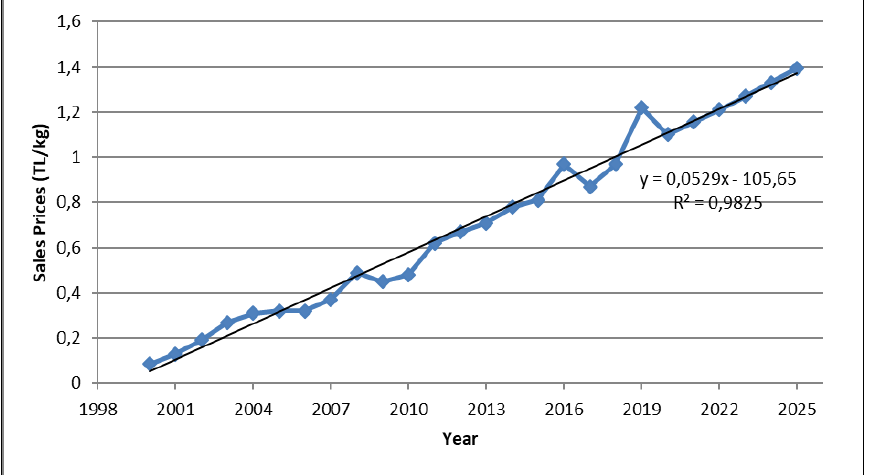
Figure 7. Oats sales price in Turkey